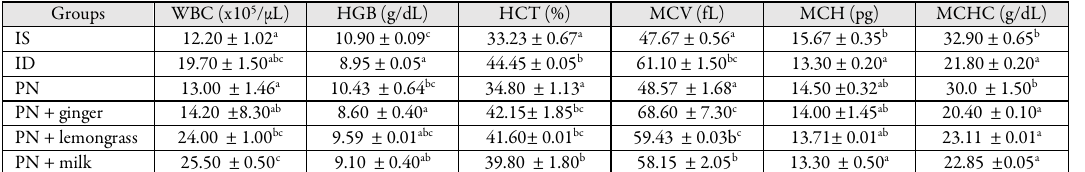
Values are means of 3 determinations ± SEM. Values with different superscripts down the column are significantly